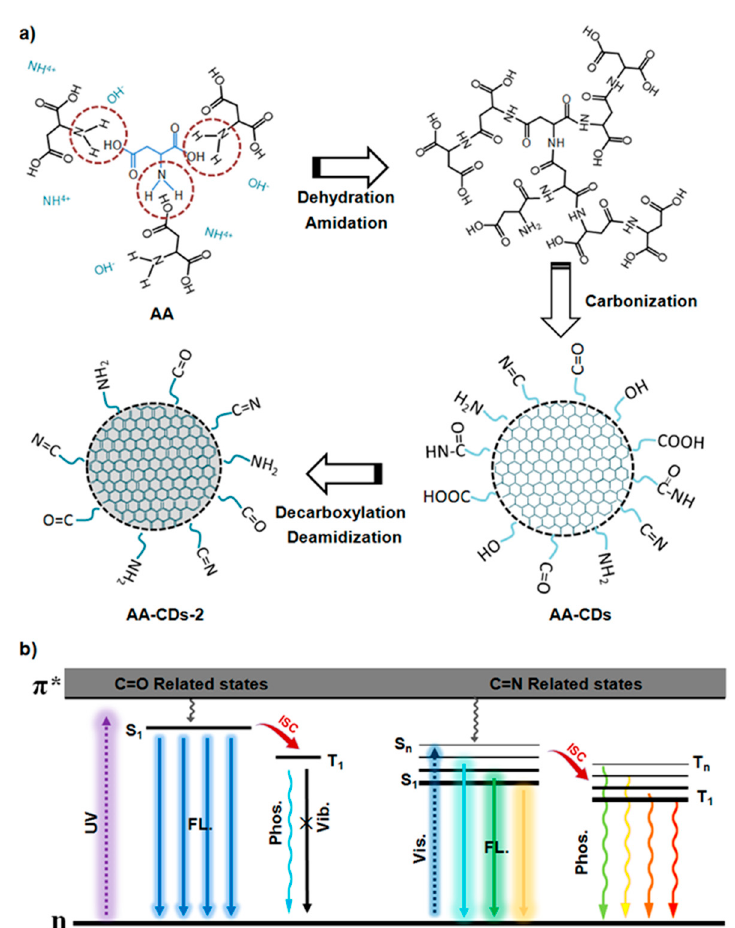
Figure 4. ( a ) A schematic illustration of the formation process from AA to the AA-CDs and AA-CDs-2. ( b ) Proposed FL and phosphorescence emission processes of the AA-CDs.